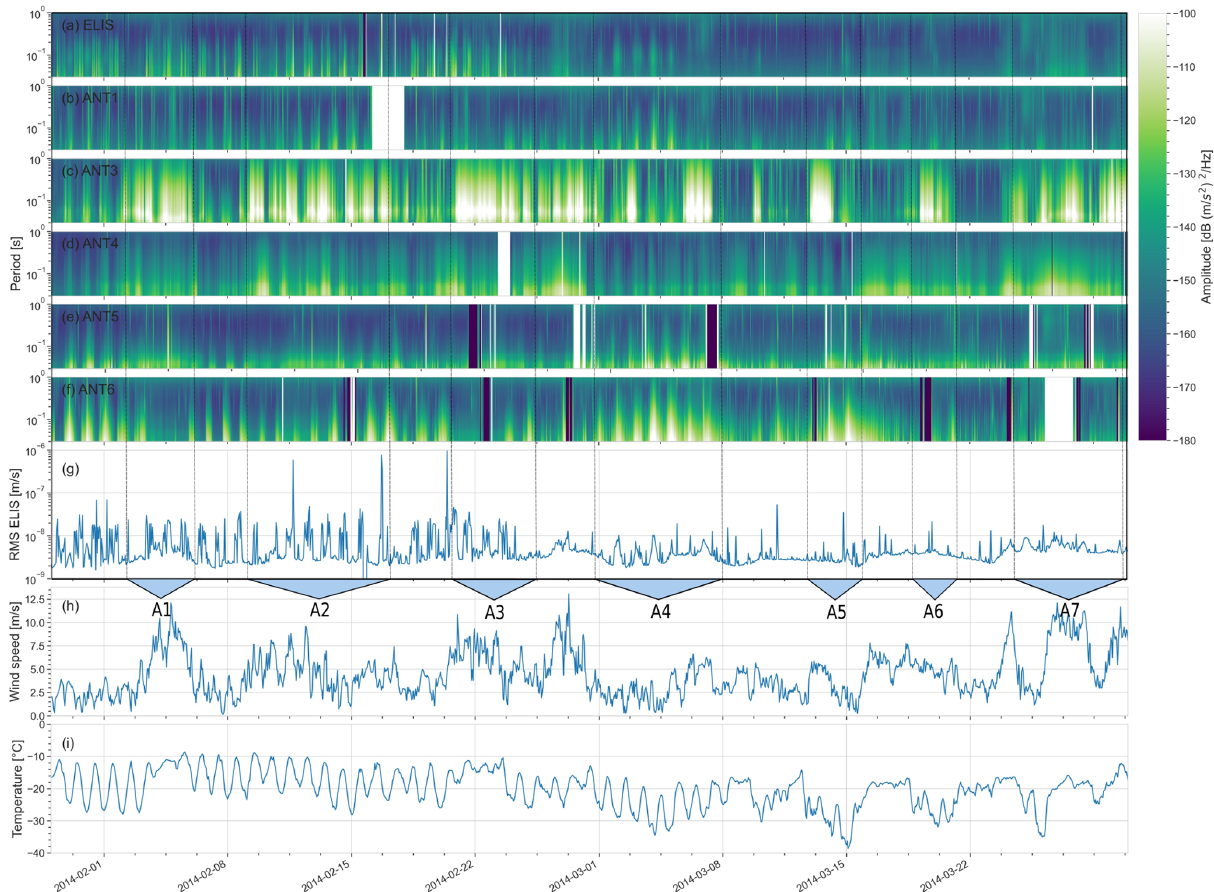
Figure 6. Belgian Antarctica network spectrograms (1–50Hz) without wind noise for the 29 January–30 March 2014 period with the RMS for ELIS and the average wind speed (ms − 1 ) and temperature ( ◦ C) for the same period from the AWS station at ELIS. A1–A7 represent periods of increased